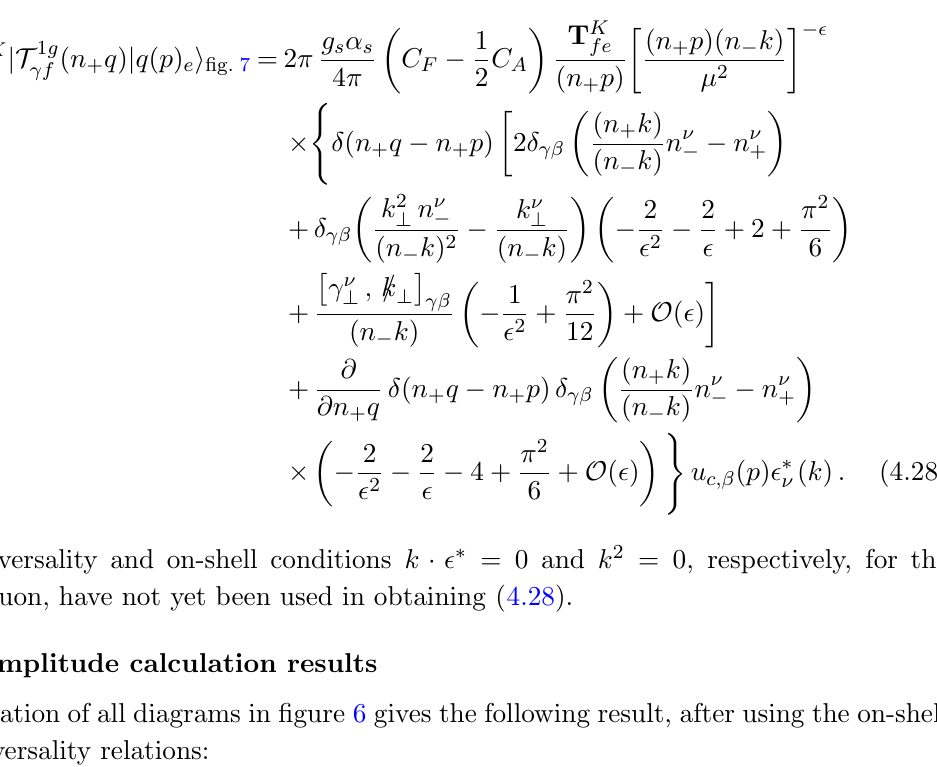
(2) (2) (2) and , and , 1 (cid:24) 2 (cid:24) 4 (cid:24) L L L